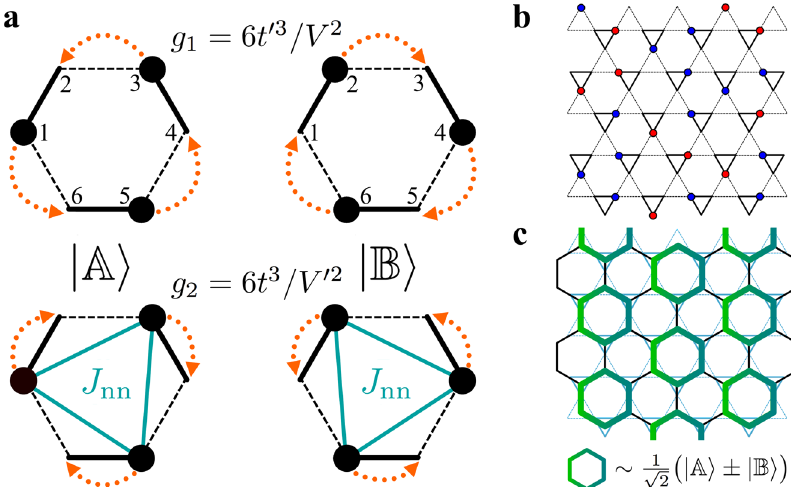
Fig. 3 Quantum dimer model on the kagomé lattice. a Ring tunnelling processes in the hexagon. Black circles represent resonating electrons. b Possible charge order minimising the intersite Coulomb interactions in the strong interaction limit. Blue and red circles stand for the spin-up and spin-down electrons, respectively. c Plaquette charge ordered phase on the dual hexagonal lattice. Green plaquettes indicate resonating